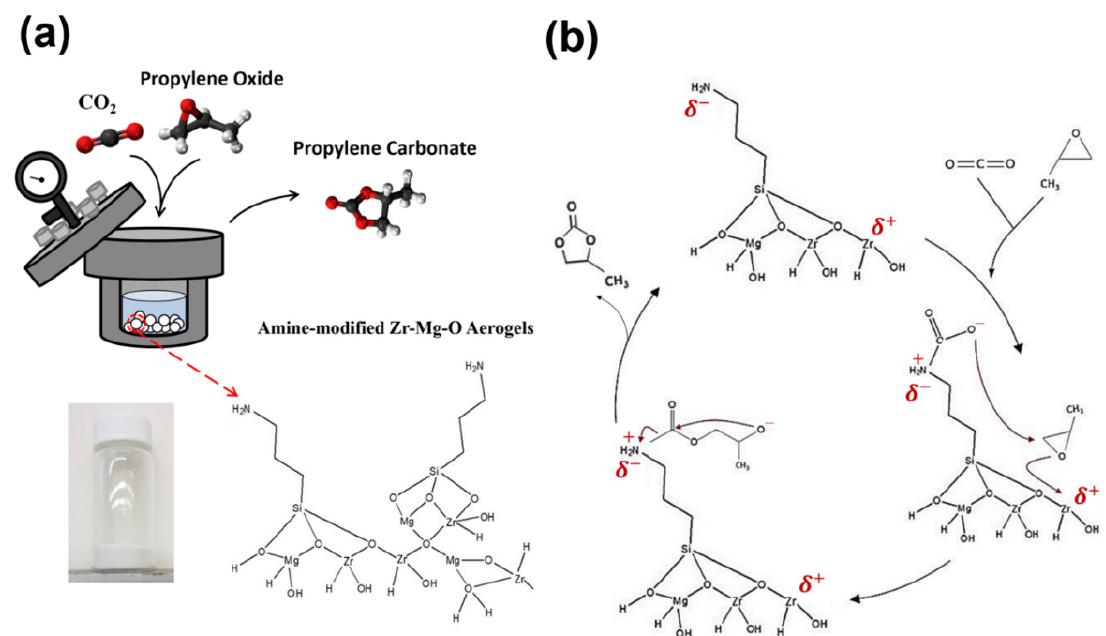
Scheme 2. The scheme for the catalysis of CO 2 /PO cycloaddition reactions using ( a ) APTMS-modified Zr–Mg mixed oxide aerogels and ( b ) their reaction mechanism.